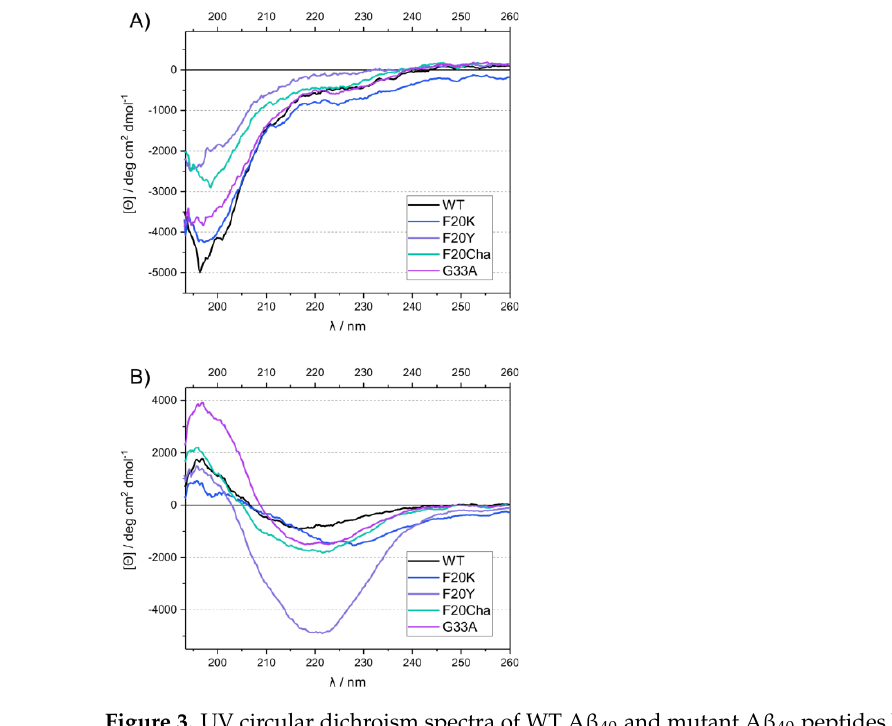
Figure 3. UV circular dichroism spectra of WT A β 40 and mutant A β 40 peptides before ( A ) and after incubation ( B ).